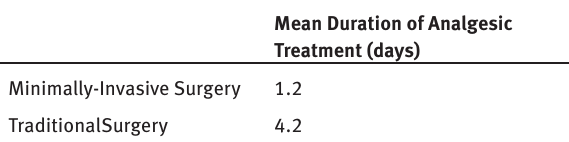
Table 2.2: Mean duration of analgesic treatment